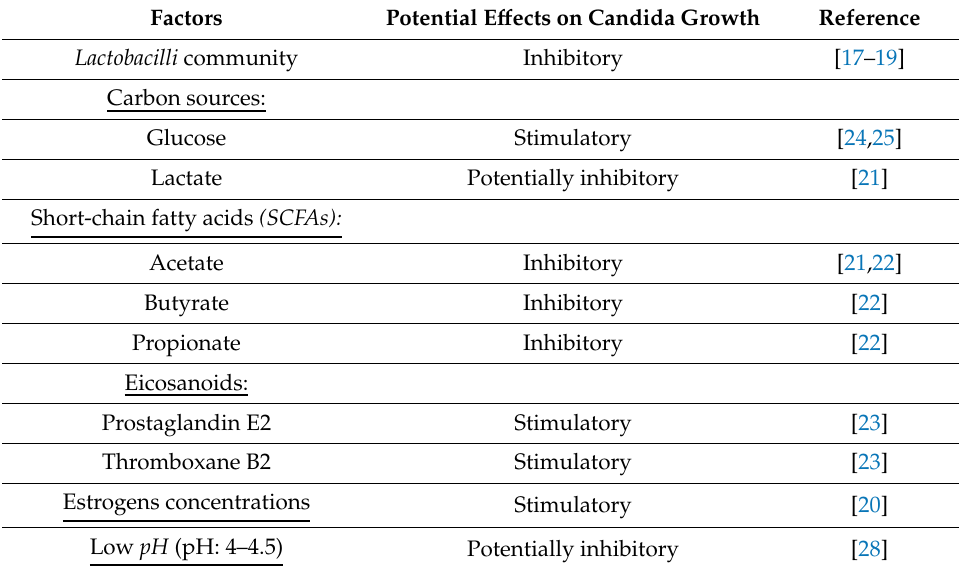
Table 1. Summary of the microbiological factors that act in quorum sensing of vaginal microbiota with potential stimulatory or inhibitory e ff ects on Candida growth / morphological